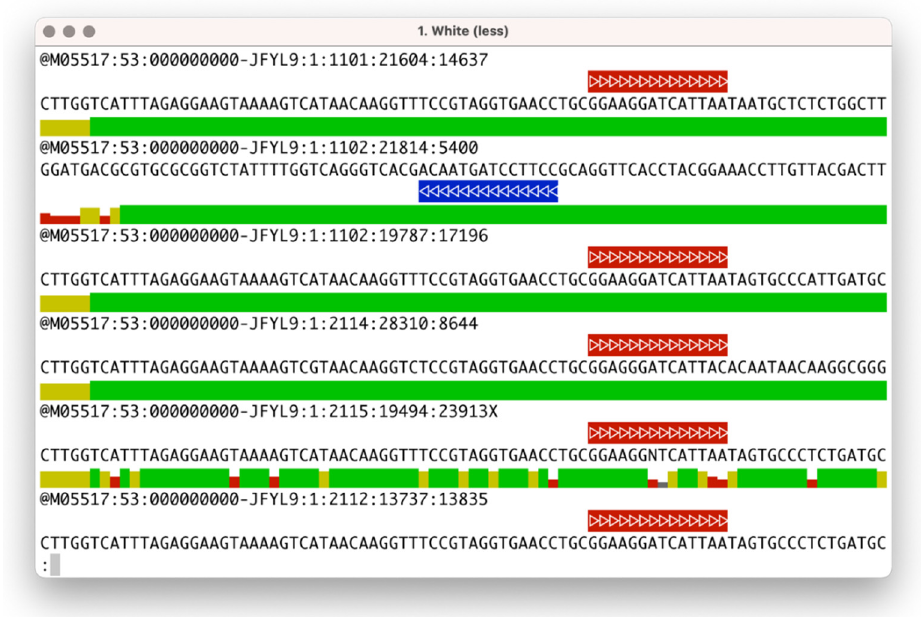
Figure 1. Example of the rendering of a FASTQ file by seqfu view , where the quality track is represented by a block of variable height and colors (gray, red, yellow, and green) and oligonucleotide matches are rendered as colored arrows.